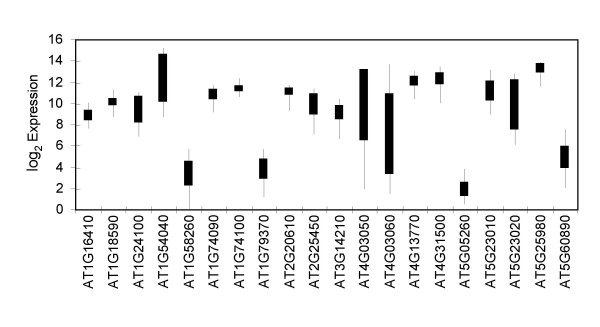
Variation in gene expression for the Glucosinolate (GS) gene network in Bay-0 × Sha RILs. Box plot showing the average (+/- one) standard deviation range of log2 gene expression in the 148 Bay-0 × Sha RILs for each of the 20 gene members of the GS network. Vertical lines represent the position of the minimal and maximal average gene expression value among the GeneChips corresponding to two biological replicates of each of 148 Bay-0 × Sha RILs.